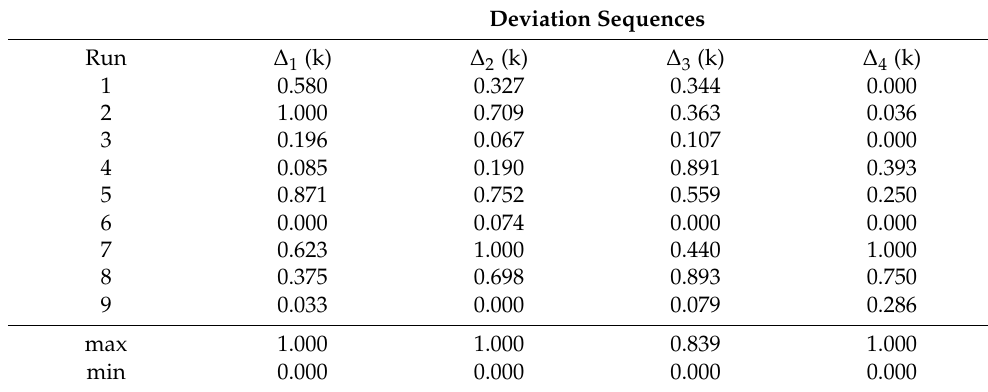
Table 6. The deviation sequences of multiple